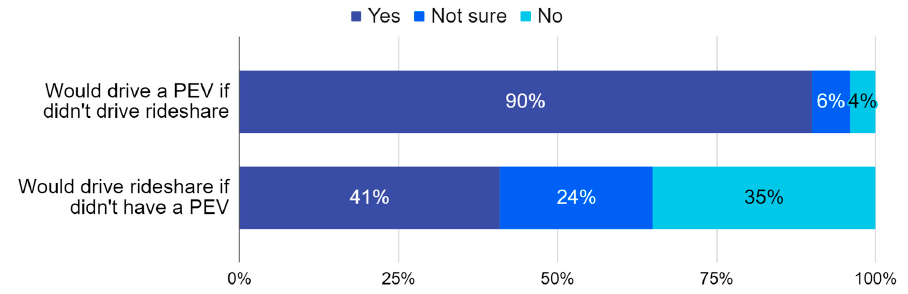
Figure 7. Commitment to PEV relative to commitment to ride-hailing job.